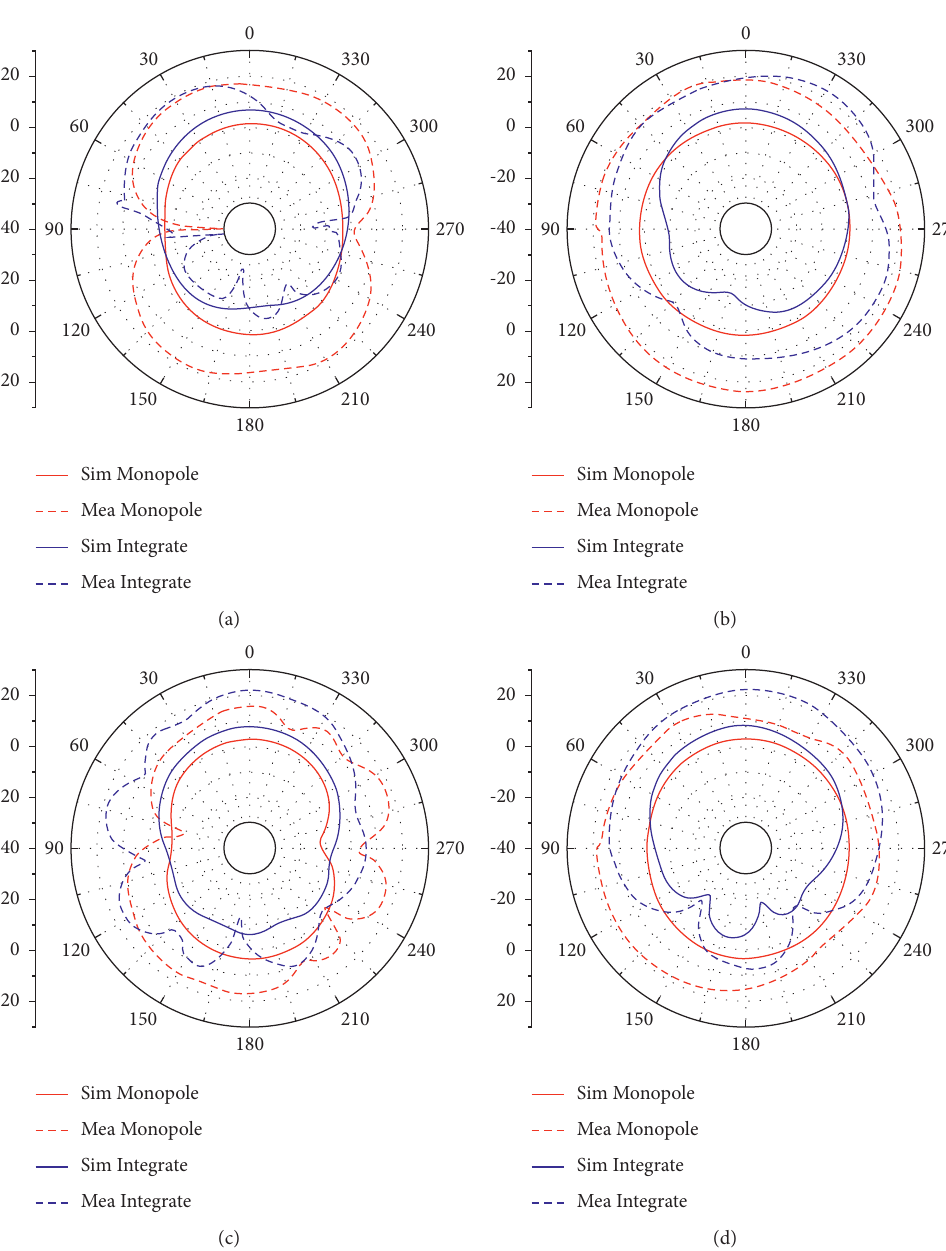
Figure 8: Radiation pattern of antenna: (a) 2.45 GHz in E-plane, (b) 2.45 GHz in H-plane, (c) 5.8 GHz in E-plane, and (d) 5.8 GHz in